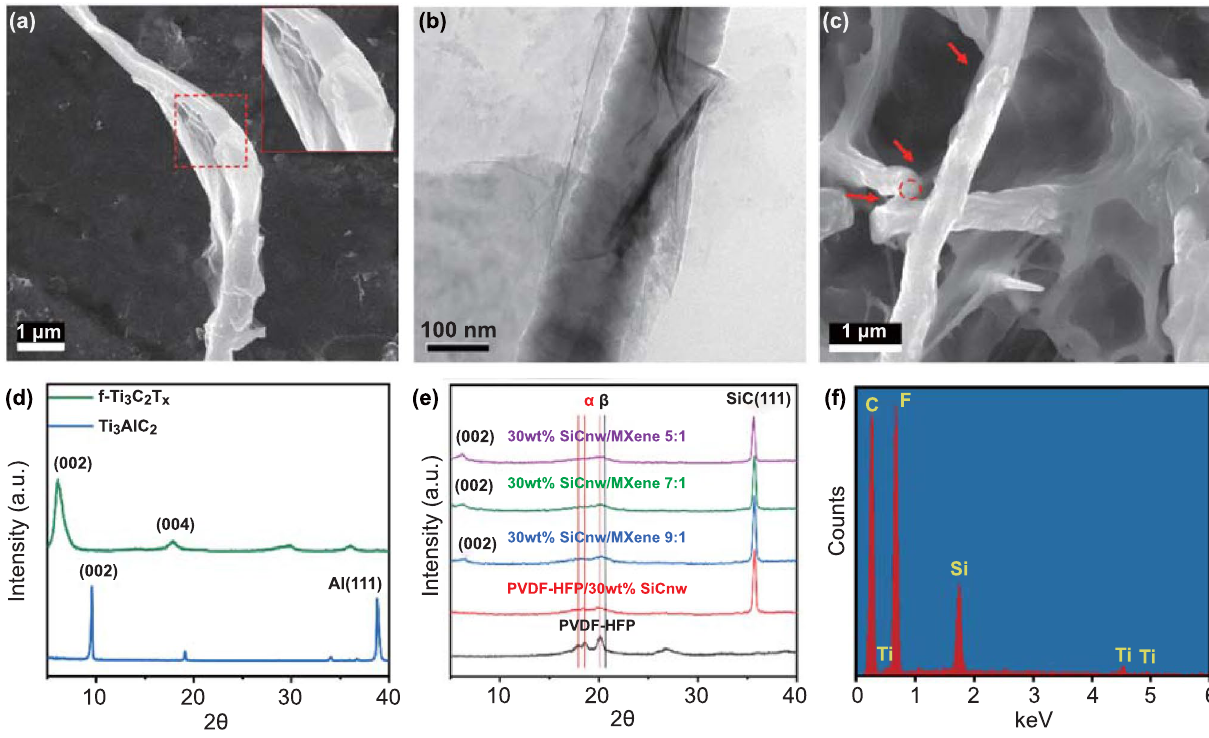
Fig. 2 a SEM image of self-assembled SiCnw@Ti 3 C 2 T x nanostructure; b TEM image of SiCnw@f- Ti 3 C 2 T x ; c EDX-SEM image of PVDF- HFP/SiCnw@MXene composite foam (30 wt%, 45% VF); d XRD patterns of Ti 3 AlC 2 , Ti 3 C 2 T x ; e XRD patterns of PVDF-HFP composites; f EDX pattern of the red circle in